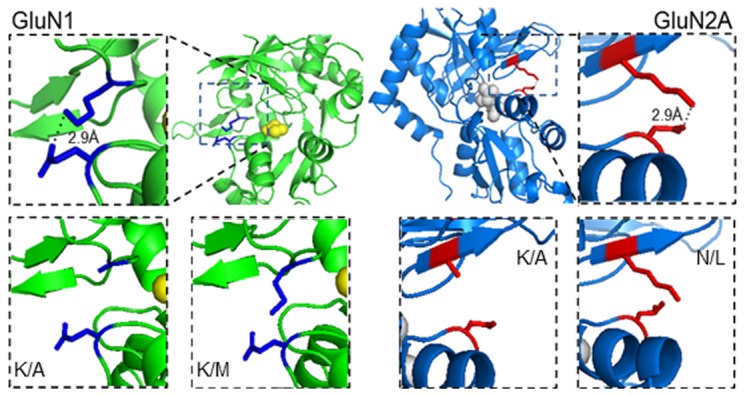
Putative cleft-spanning interactions in the LBD of GluN subunits.
Top, proposed arrangements of the LBDs of glycine-bound GluN1(left, PDB 1PB7) and glutamate-bound GluN2A (right, PDB 2A5S) illustrate the position and cross-cleft distance of K483 and E712 (2.9 Å), and K487 and N687 side chains (2.9 Å), respectively. Bottom, PyMol representations of the substitutions examined in this study showing cross-cleft distances: right, N1K/A 7.0 Å and N1K/M 3.1 Å; left, N2K/A 5.5 Å and N2N/L 2.6 Å.